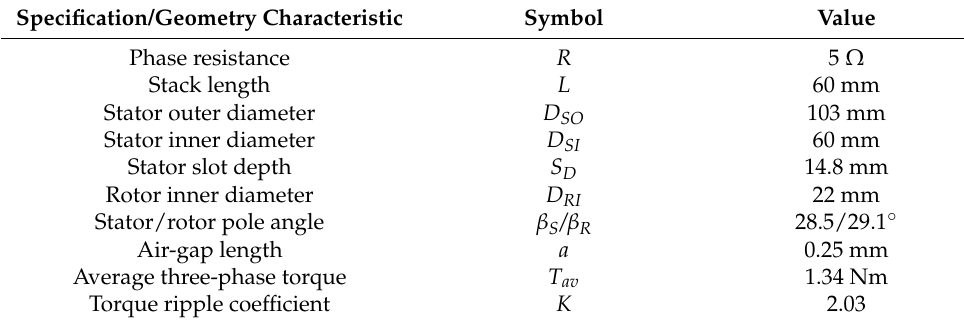
Table 1. Motor specifications and geometry